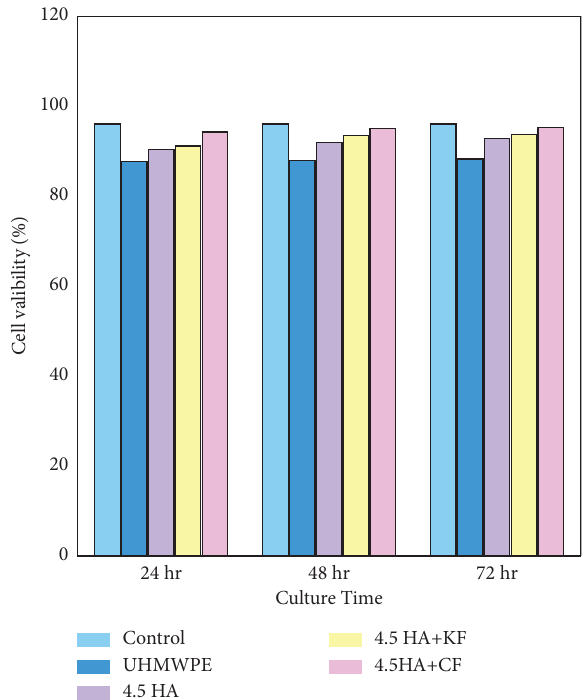
Figure 7: Cell availability of biocomposite bone plates fxation as a function of hydroxyapatite nanoparticles.